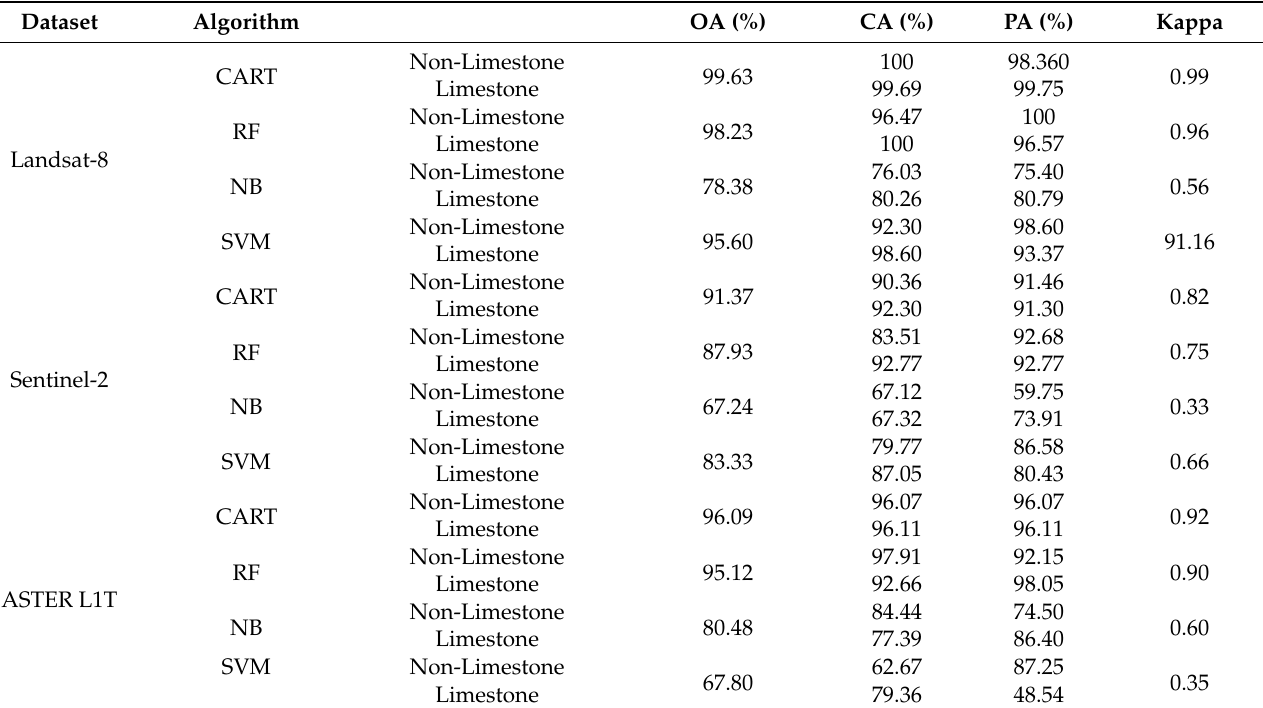
Table 4. Comparison of CART, random forest, naive Bayes, and SVM accuracy for Landsat-8, Sentinel-2, and ASTER data.